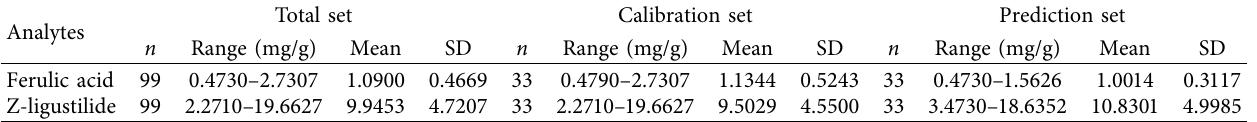
Table 3: Contents of ferulic acid and Z-ligustilide determined by